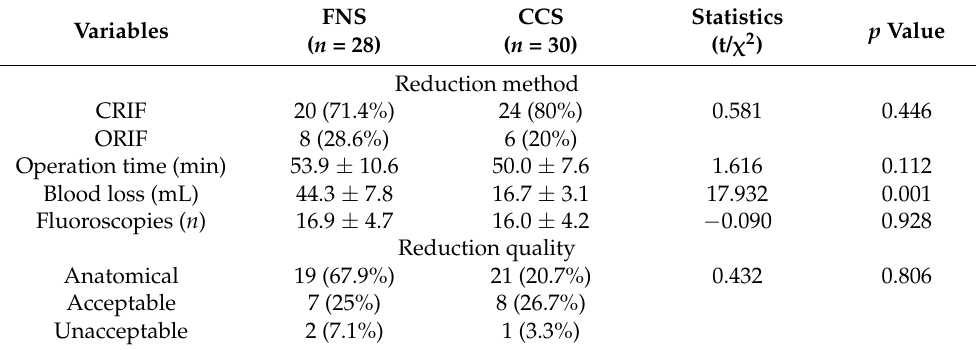
Table 2. Comparison of operative